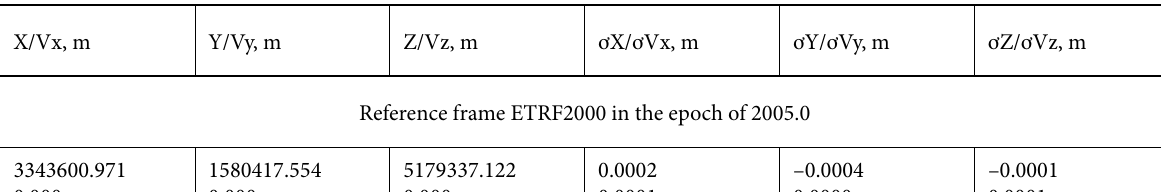
Table 1. The positions (geocentric coordinates), velocities and accuracy (cumulative solution of GPS weeks 860–160) of the VLNS station